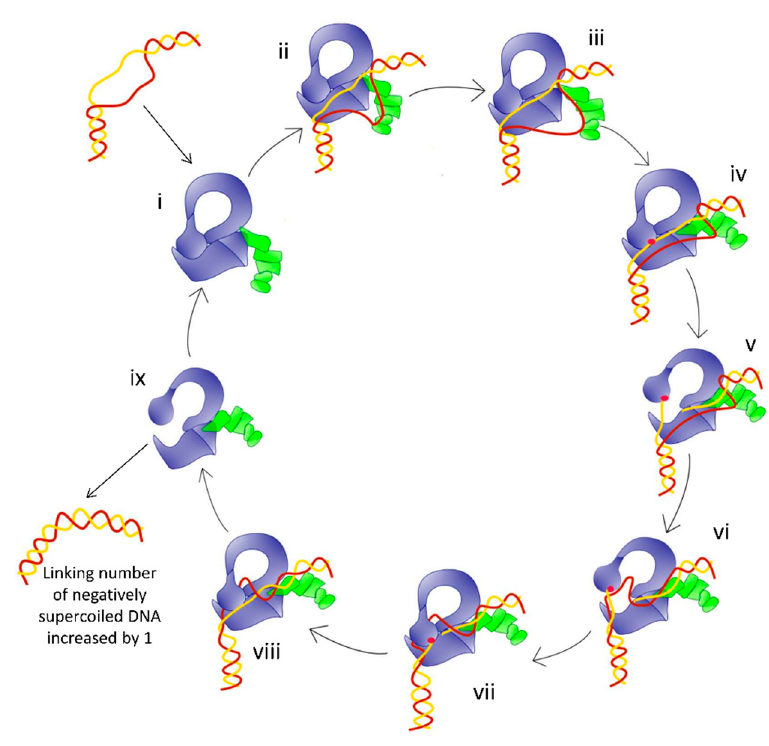
Figure 5. Model for the relaxation of supercoiled DNA by bacterial topoisomerase I based on the crystal structures of E. coli and Mycobacteria topoisomerase I. (i) Apo enzyme; (ii) C-terminal domains (green) bind ssDNA as T-strand (red); (iii) ssDNA or G-strand (yellow) binds the N-terminal domains (blue); (iv) Active site tyrosine (red circle) becomes accessible; (v) Cleavage of the G-strand and gate opening; (vi) Passage of T-strand inside the toroid; (vii) Gate closing and trapping of T-strand; (viii) Religation of the G-strand; (ix) Gate opening and release of dsDNA.